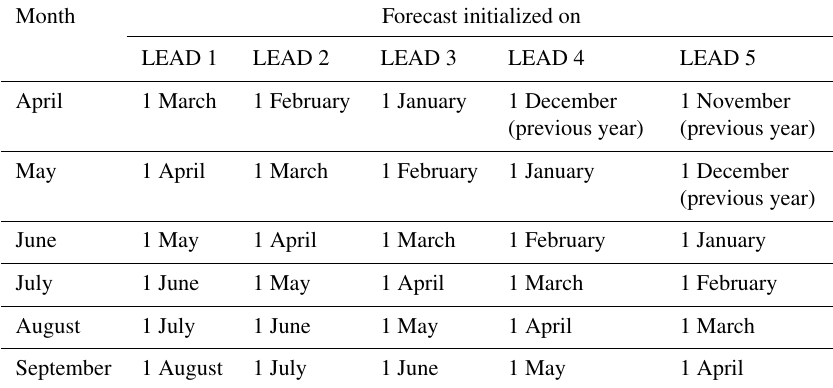
Table 2. Initialization times for different target